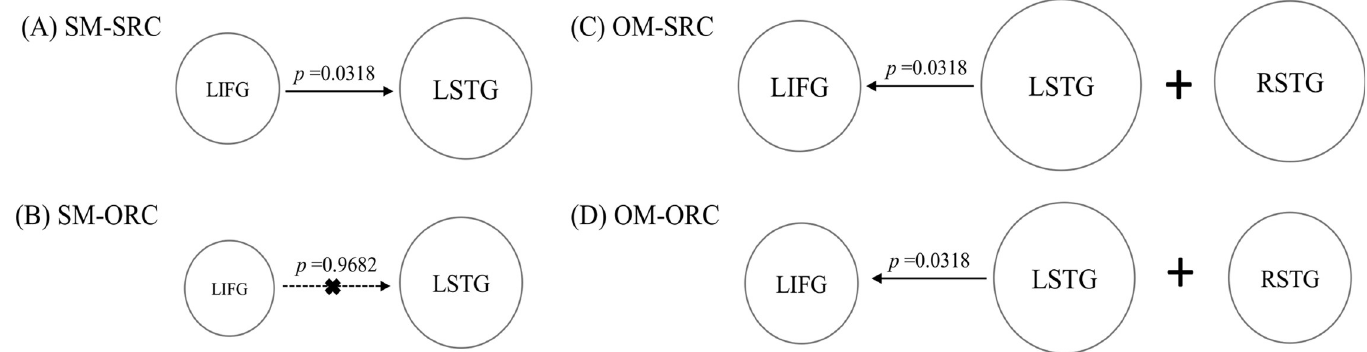
Fig 5. The simplified graph for the processing mechanism involved in the RC sentences with different levels of processing difficulty. The results illustrate A) The activation of the LIFG and the LSTG, as well as the connectivity from the LIFG to the LSTG, is involved in the processing of the SM-SRCs; B) No evident functional communication between the LIFG and the LSTG is found in the reading of the SM-ORCs, although relatively less activation in the LIFG and the LSTG is still needed; C) The activation in the LIFG and also in the LSTG and its right homolog, as well as the effective connectivity from the LSTG to the LIFG, together facilitate the processing of the OM-SRCs; D) Compared with the OM-SRCs, the similar neural mechanism is involved in the reading of the OM-ORCs, although the activation of the LIFG is significantly less in the OM-ORCs compared to that in the